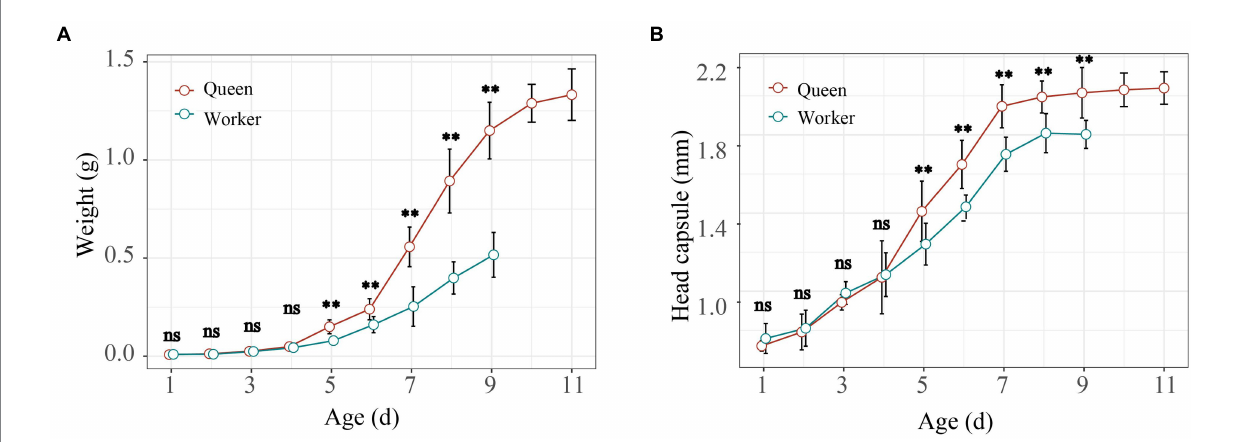
FIGURE 2 Larval growth and development curve of larvae in Bombus terrestris . The weight (A) and head capsule (B) of worker and queen larvae during their entire development ( t -test; ns represents p > 0.05, * represents p < 0.05, ** represents p <